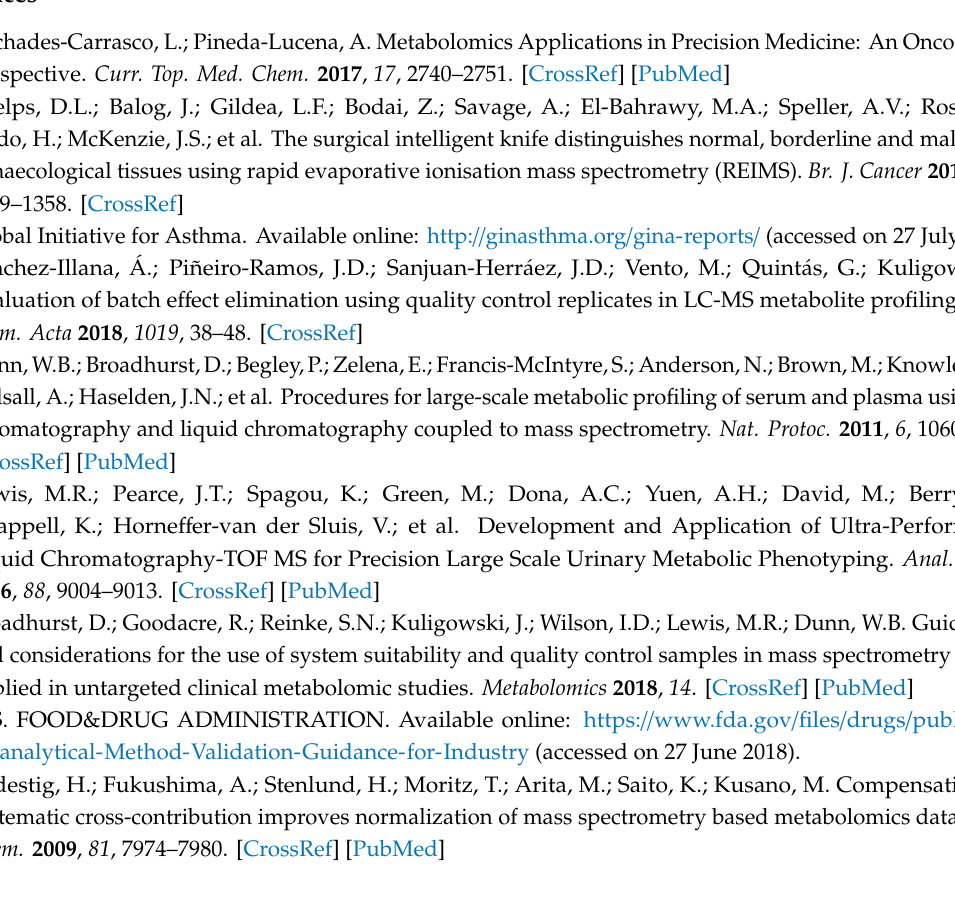
according to the injection order, Figure S5: PCA models of initial data (before normalization), Figure S6: Outcome of the data normalization strategy by the IS mix for both: ESI + and ESI − modes, Figure S7: Contribution of PC1 and PC 2 along with injection order in ESI − mode after normalization by IS mix, Figure S8 : Outcome of the data normalization strategy by the TUS for both: ESI + and ESI − modes, Figure S9: Normalization impact evaluated by PCA models of all experimental samples in the study, Figure S10: Normalization assessment by PCA of repeated experimental samples for raw data; after normalization by QC-SVRC and QC-SVRC + QC-norm., Figure S11: Euclidean distances plots of repeated experimental samples, Figure S12: Abundance plots before and after normalization of LPC 20:0, RT 29.5 min, Figure S13: Venn diagram comparing the number of significant features between two groups of the clinical study before normalization (raw data) and after QC-SVRC + QC-norm normalization., Table S1: IS mix adducts detected in the